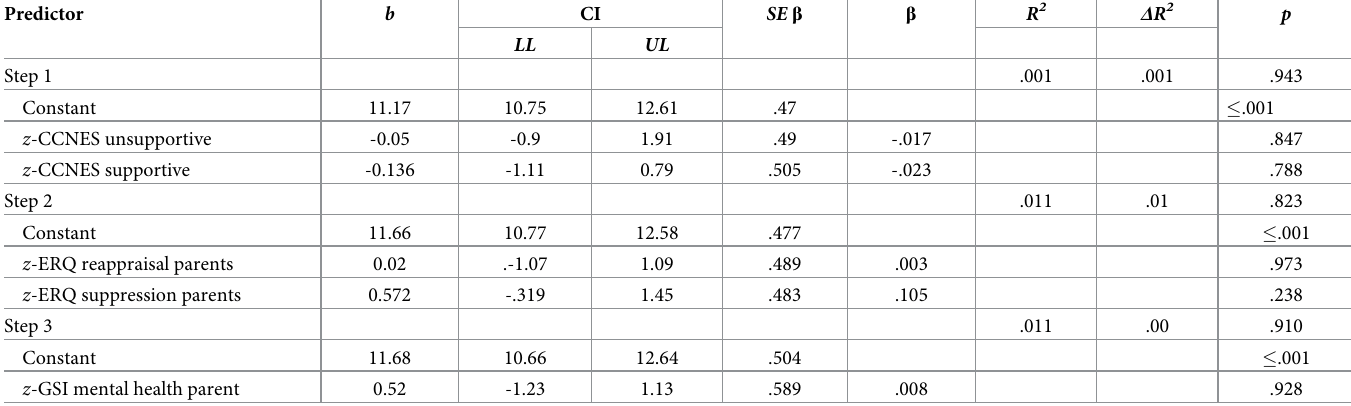
Note . N = 139. CI = Confidence interval (based on 1,000 bootstrapped samples); LL = lower limit; UL = upper limit; z-CCNES = mean z-standardized score on the Coping with Children’s Negative Emotions Scale; z-ERQ = mean z-standardized score on the Emotion Regulation Questionnaire; z-GSI = mean z-standardized score on the Global Severity